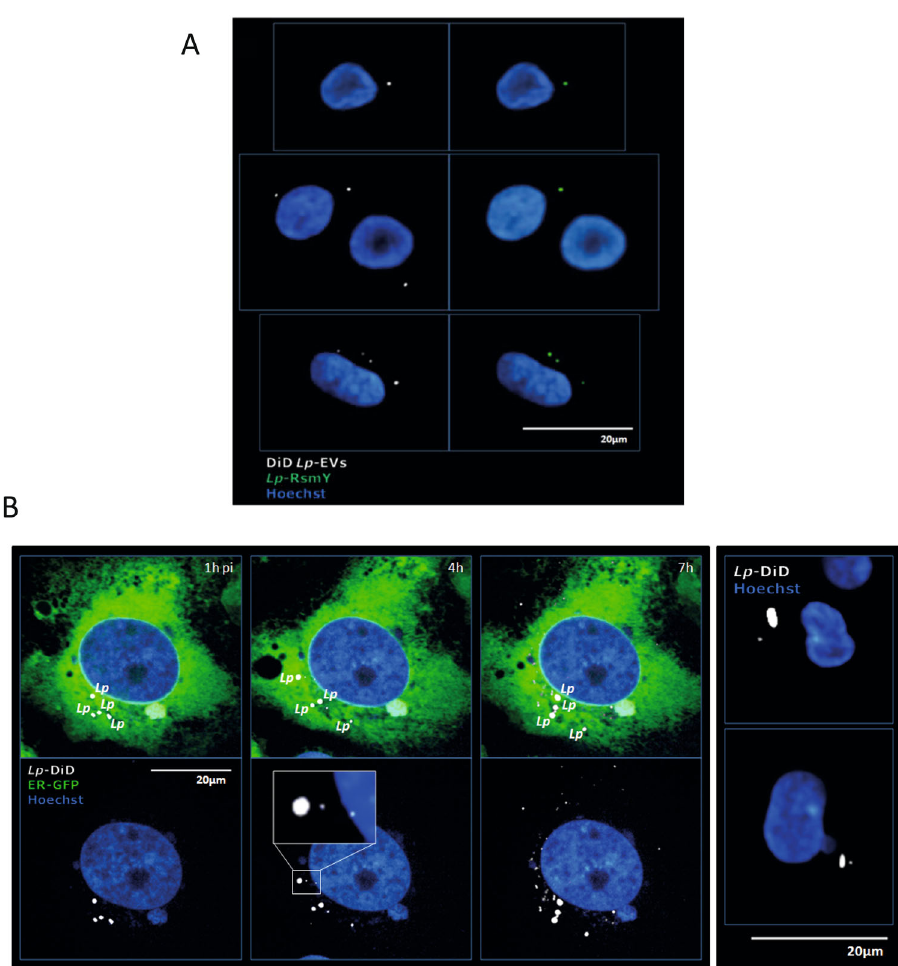
Fig. 2 Lp -EVs are shed during infection and contain RsmY. A Representative images of three independent experiments from FISH analyses using probes speci fi c for RsmY. hMDM cells incubated with puri fi ed DiD-labelled Lp -EVs. Internalized, DiD-labelled Lp- EVs (white) 5 h post-infection. Blue, nucleus fl uorescently stained using Hoechst 33342. B Human bone osteosarcoma epithelial cells stably expressing Sec61 β -GFP for ER labelling (U2OS- Sec β 61 β cells; fi rst three panels) and human monocyte-derived macrophages (hMDM) (right panel) were infected with DiD-labelled L. pneumophila grown until post-exponential phase (OD4.2). Images of living infected U2OS- Sec β 61 β cells after 1, 4, and 7 h of infection at 37 °C (5% CO 2 ) taken with an automated confocal microscope (Opera) are shown. Upper panel shows the cells with the green fl orescence labelling of the ER, lower panel shows the same cells without the green channel. Representative images of three independent experiments. White: DiD-labelled L. pneumophila and DiD-labelled Lp -EVs shed during infection; Green: ER; Blue: Nucleus (Hoechst 33342). Right panel shows fi xed hMDM cells, 5 h post-infection, analyzed by confocal microscopy. White: L. pneumophila and Lp -EVs; Blue: Nucleus (Hoechst